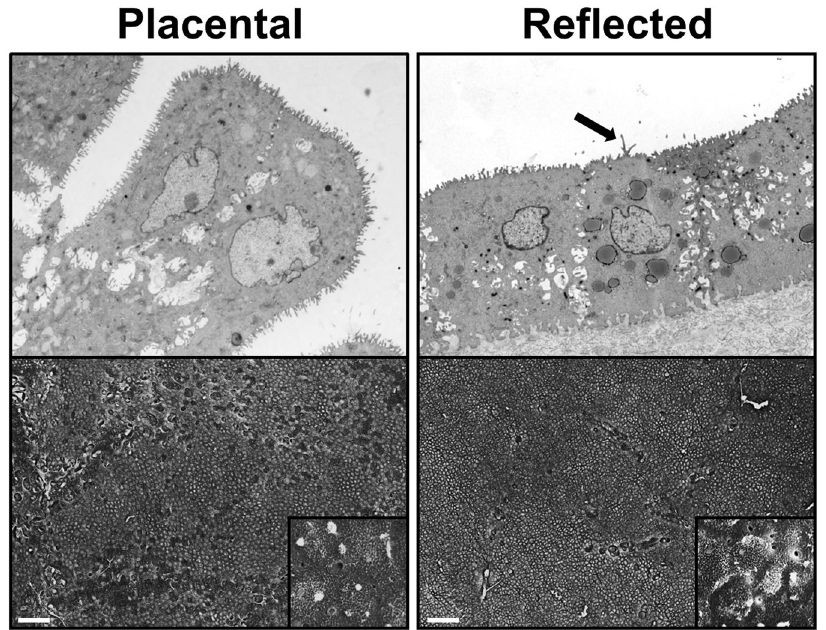
Figure 1. Ultrastructure of hAM differs between placental and reflected region. Epithelial cells of placental hAM display predominantly a columnar appearance covered with microvilli. Gaps between the cells are visible. Reflected hAM-derived epithelial cells are cuboidal and exhibit regular cell morphology, microvilli and longer cell protrusions (arrow) and are present at a high density covering the basal membrane. In this subregion of hAM, secretory vesicles are abundant. Upper row: Representative TEM pictures of amnion-derived epithelial cells, 3500x magnification; lower row: Representative SEM pictures of epithelial side of hAM, scale bars: 100 µ